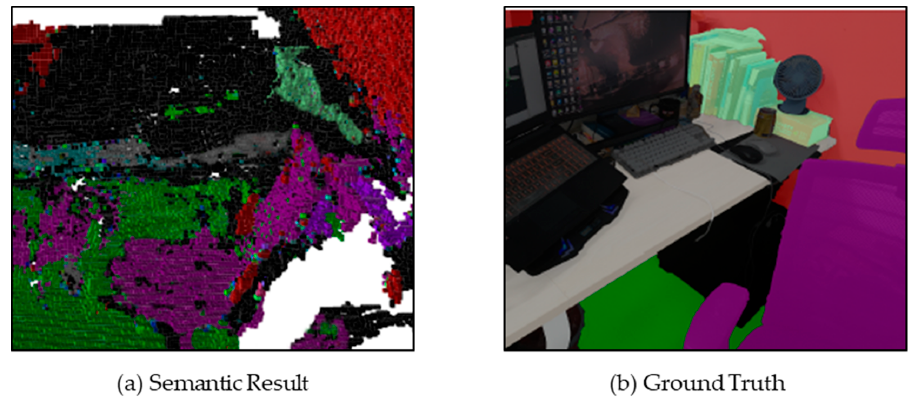
Figure 7. Semantic cloud map established in an Indoor